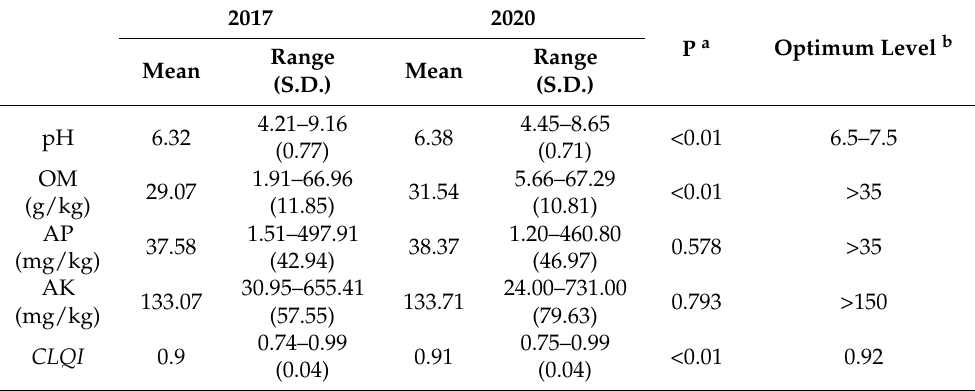
Table 2. Descriptive statistics of soil nutritional properties and cultivated land quality in 2017 and